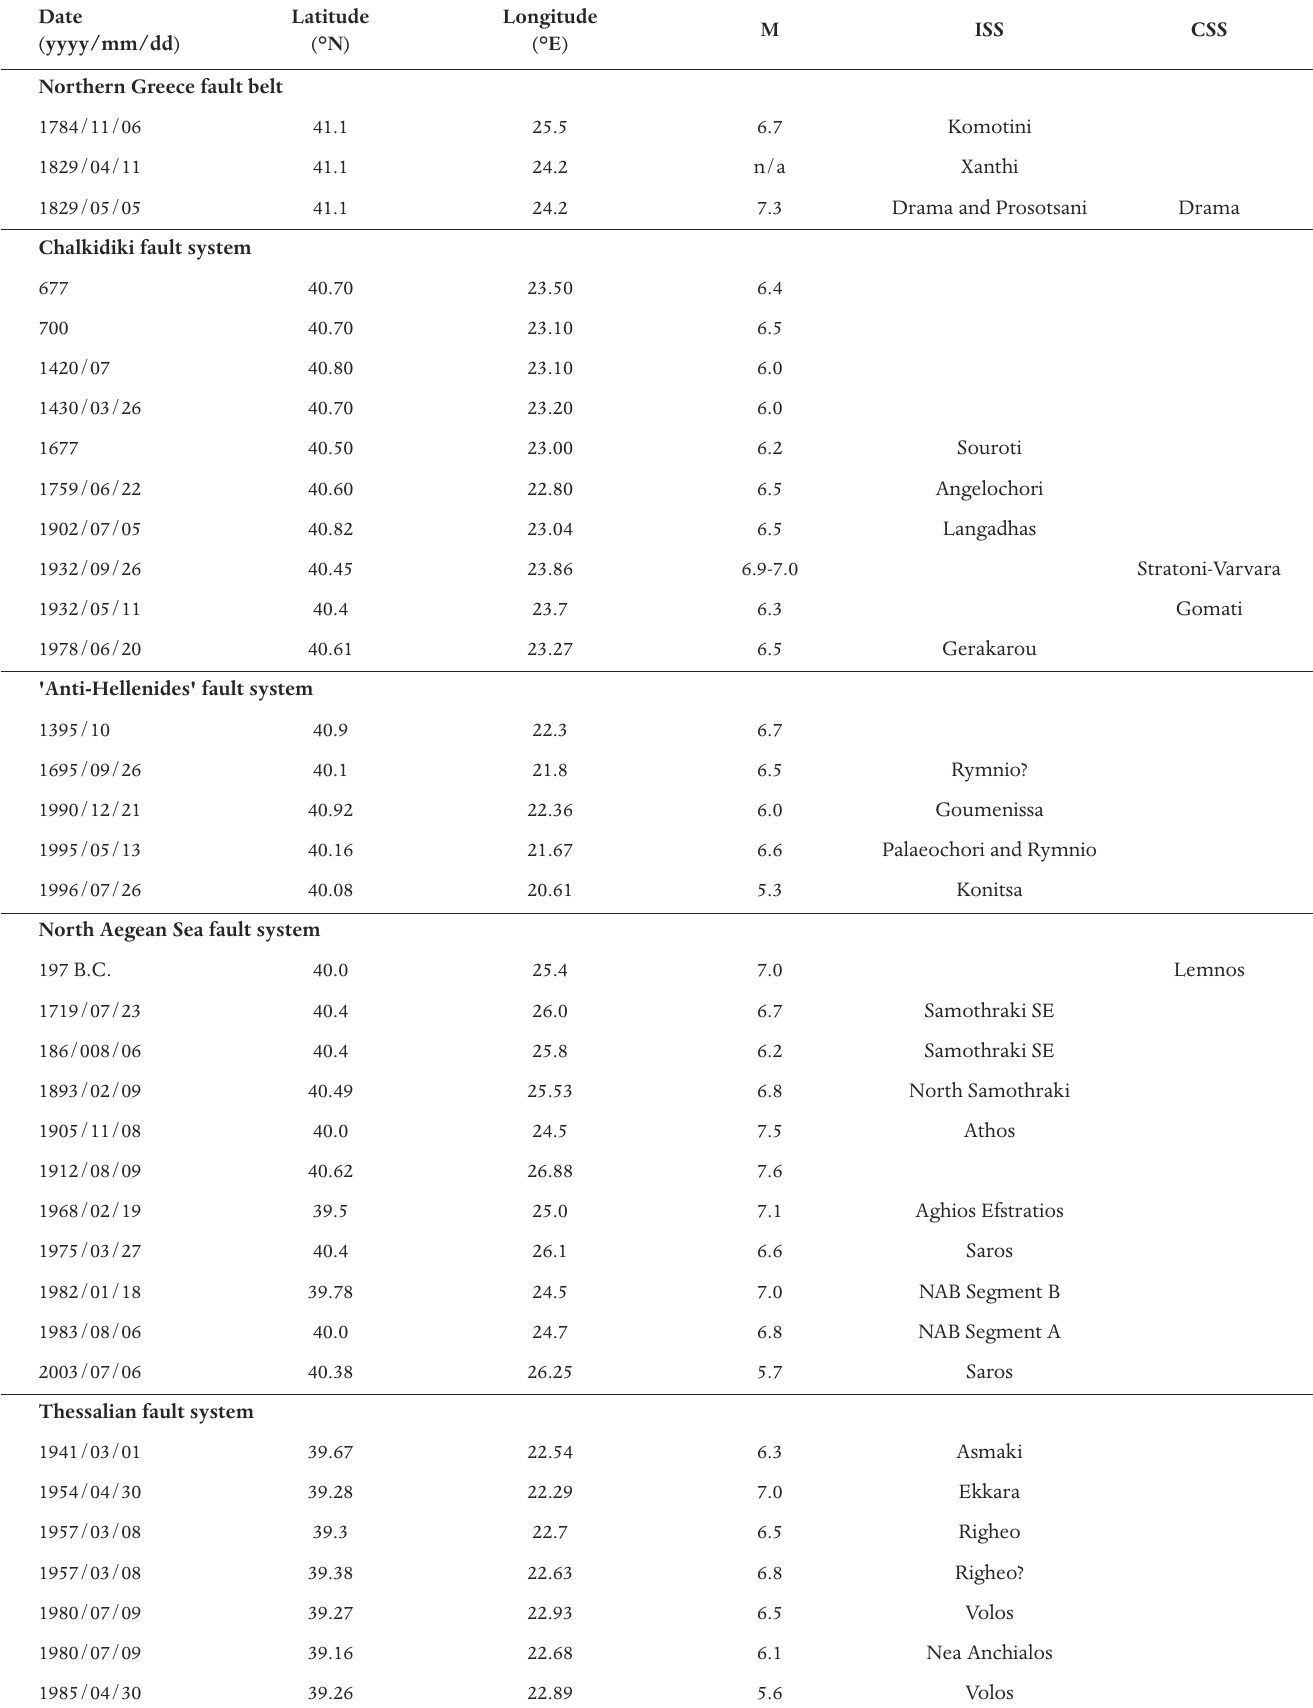
Table 1. Major historical and instrumental earthquakes of the investigated area and their likely causative seismogenic sources, as discussed in the main text [from Papazachos and Papazachou 1997, 2003, Papazachos et al. 2009]. NAB, North Aegean